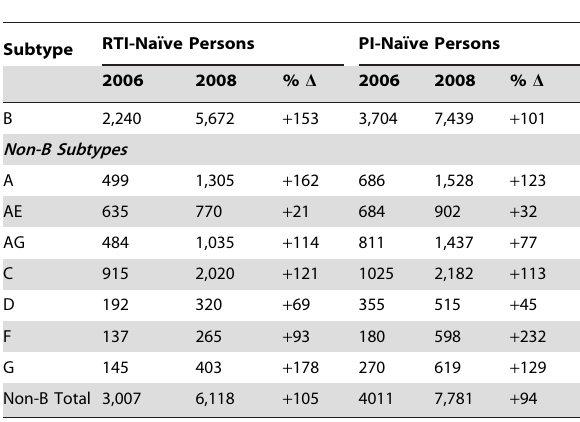
Table 1. Numbers of Reverse Transcriptase Inhibitor (RTI) and Protease Inhibitor (PI)-Naı¨ve Persons from Whom Publicly Available Sequences Were Available for Analysis in 2006 and